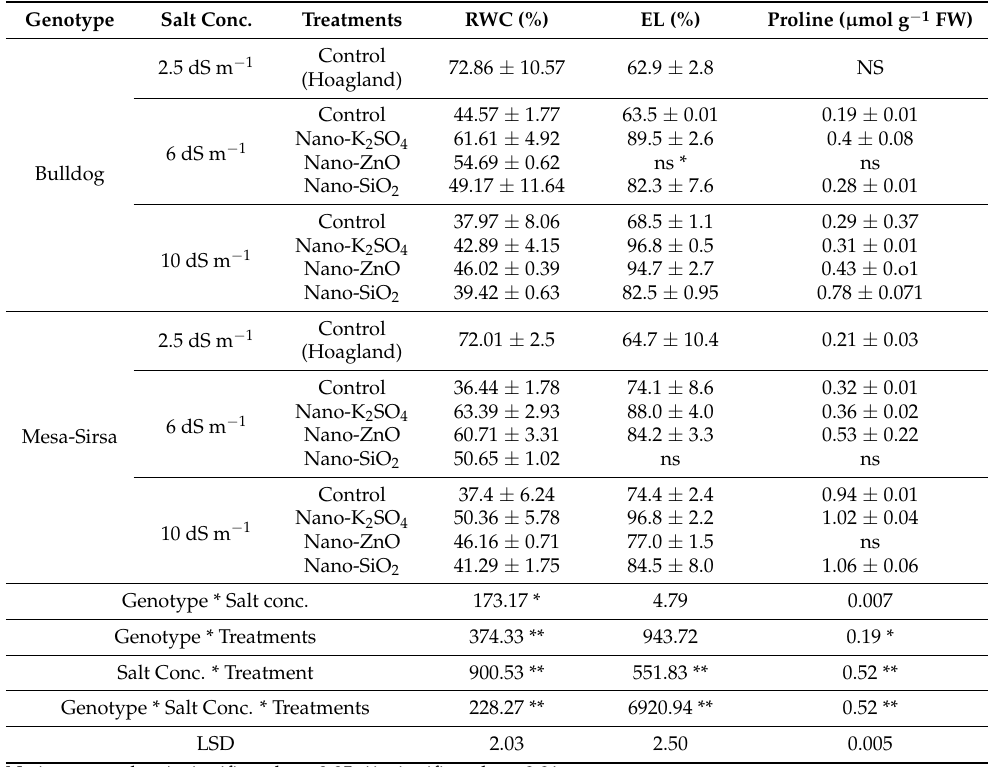
Table 2. Effect of different nano-fertilizers (K 2 SO 4 , ZnO, and SiO 2 ) on Relative Water Content (RWC), Electrolyte Leakage (EL), and Proline content to Alfalfa genotypes grown under three salt levels (control “Hoagland”, 6 and 10 dSm − 1